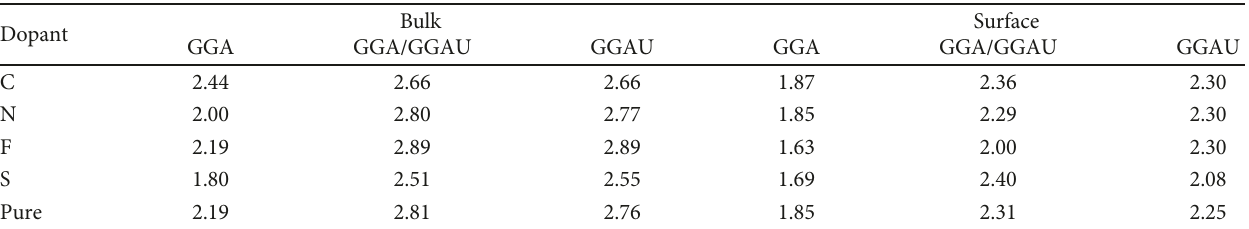
. (a) The bulk supercell. 2 . Energy units are in eV. 2